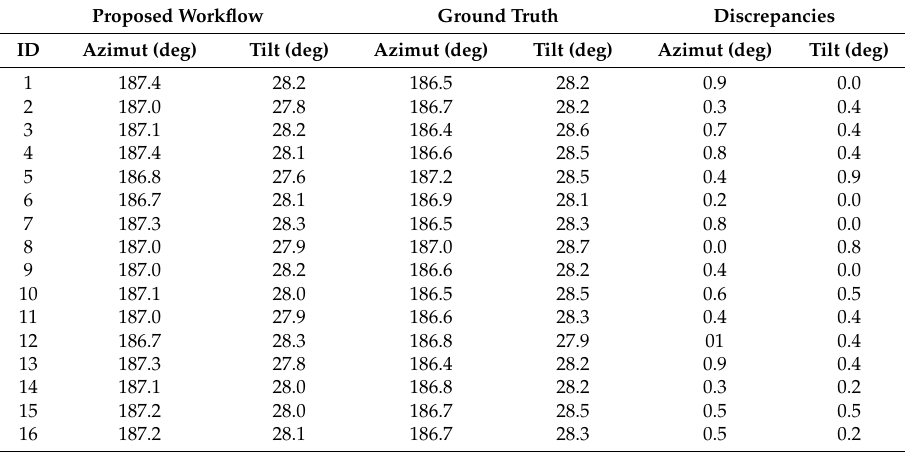
Table 7. Geometric attributes verification regarding ground